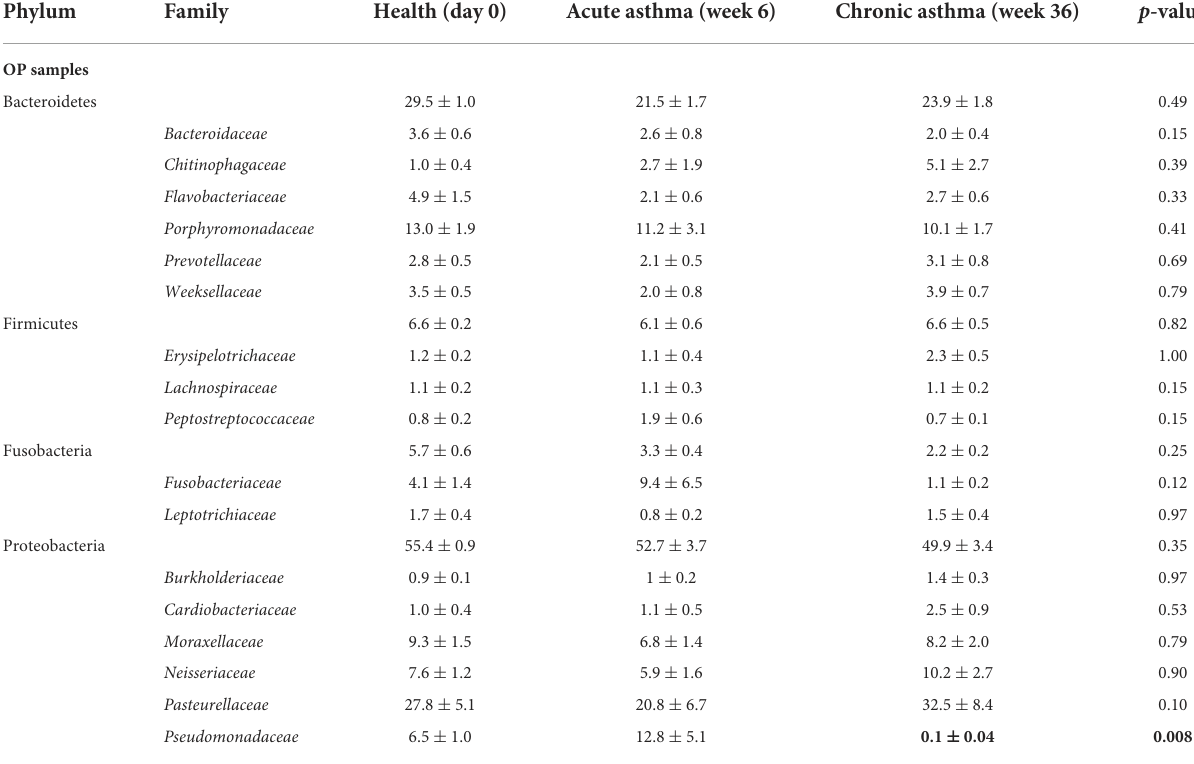
TABLE 2 Relative abundance (mean ± SEM) of taxa at the level of family present in any upper airway sample at any time point at > 0.5% accounting for > 90% of the overall microbial community. Phylum